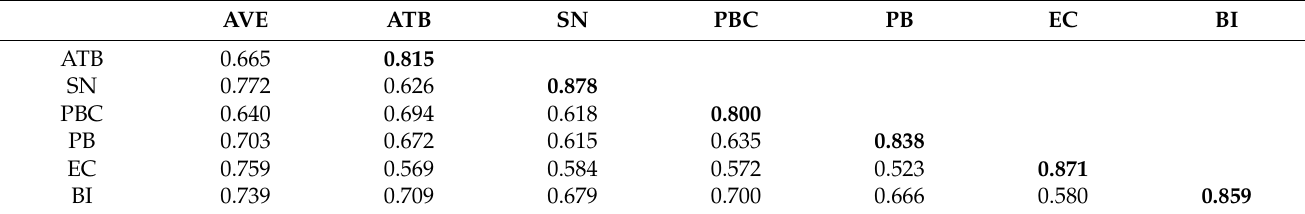
Table 4. Discriminant validity for the measurement